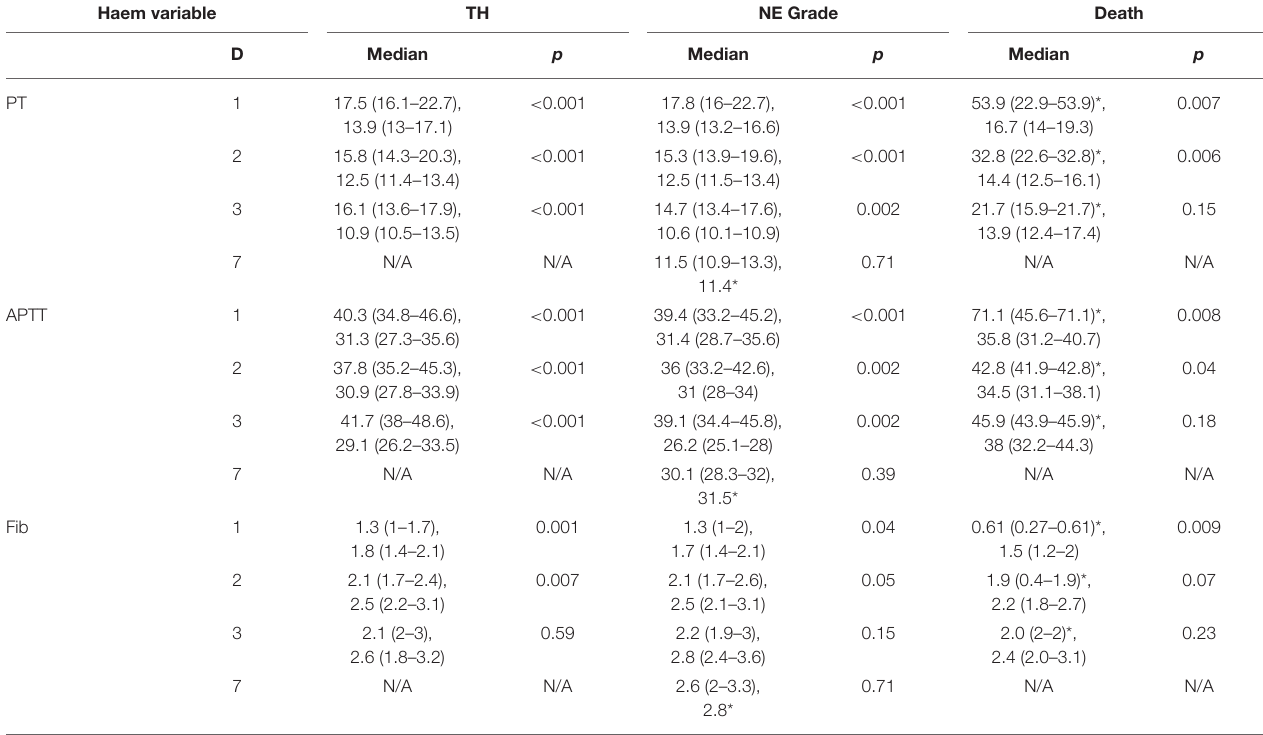
TABLE 3 | Associations between TH, outcome measures and coagulation parameters of infants with NE.